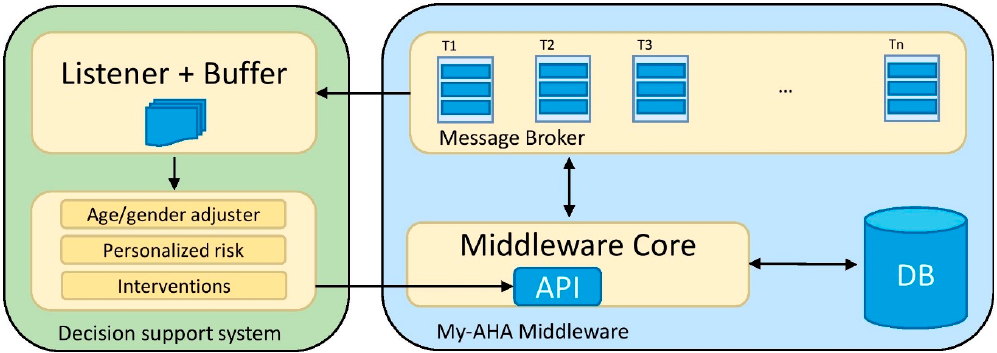
Figure 2. DSS interaction with the middleware platform.